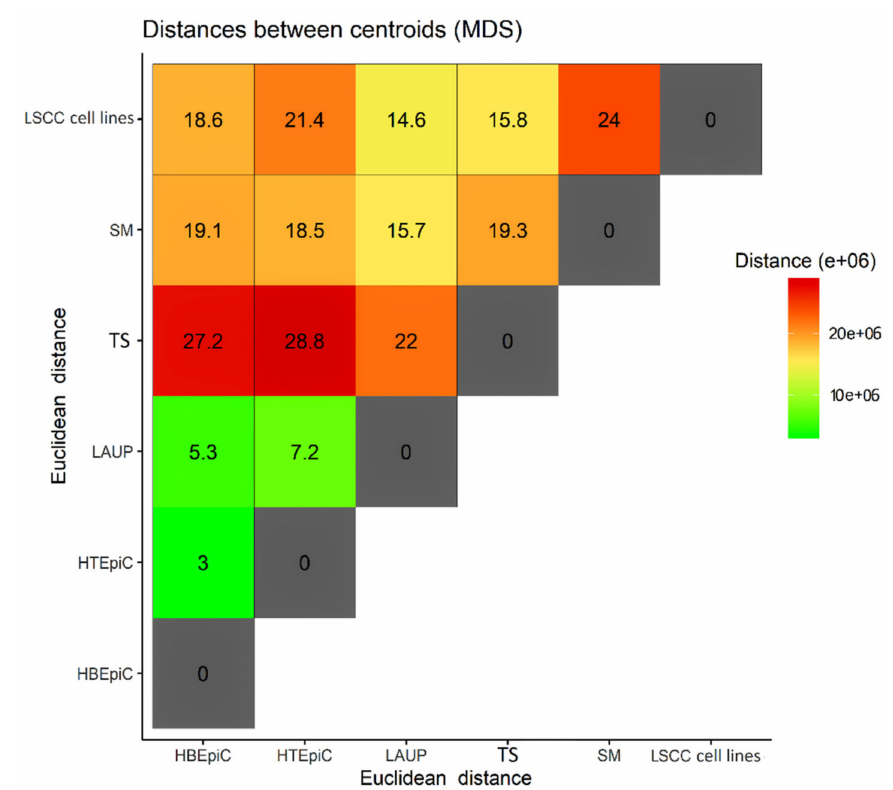
Figure 2. Distances between cohorts of studied samples.